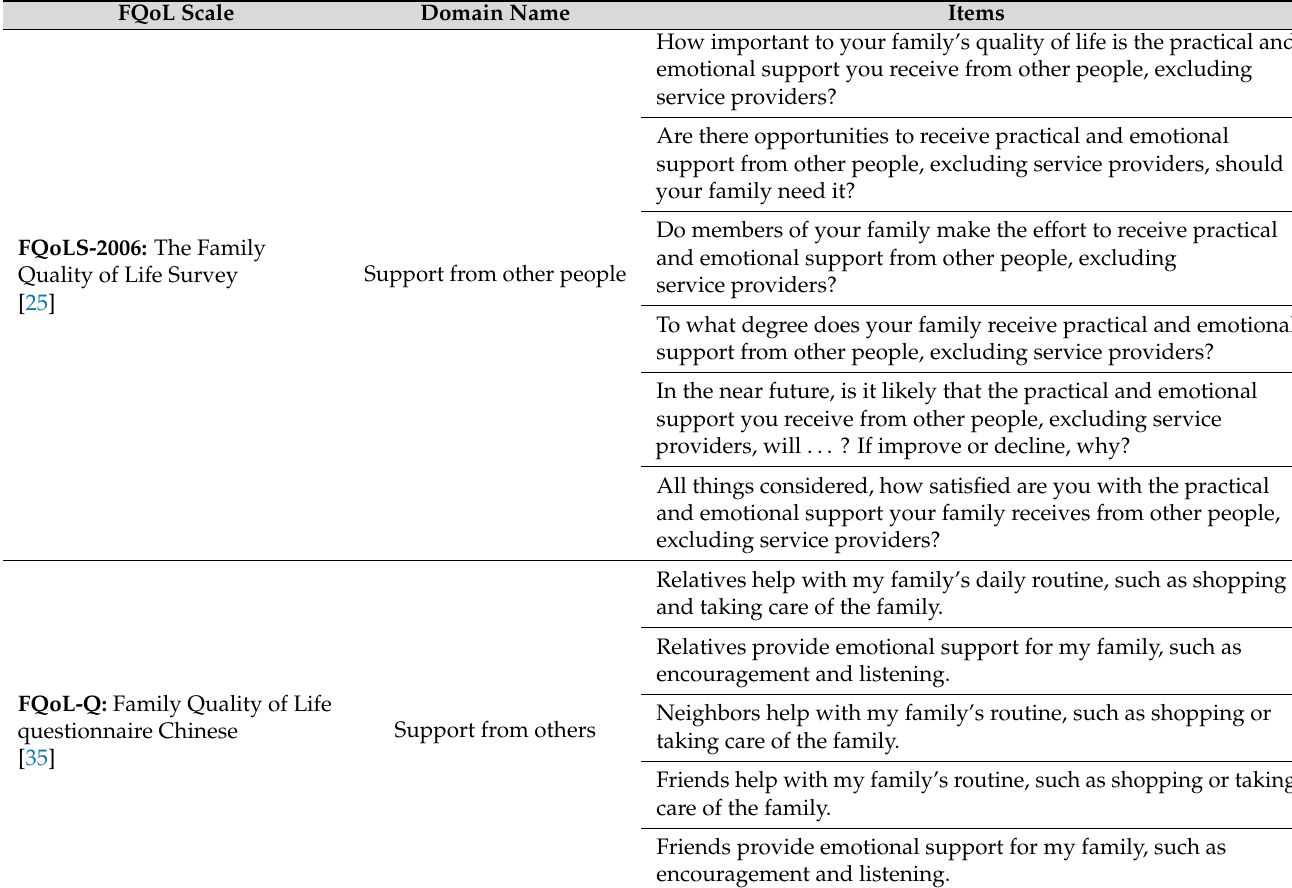
Table 6. Items considered in the domain of support from other people within each FQoL